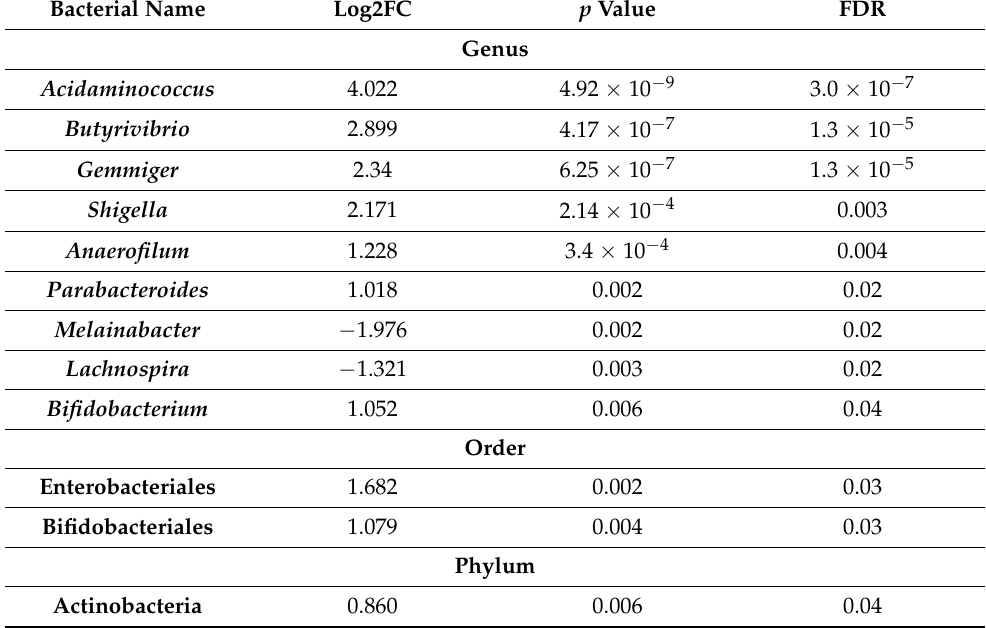
Table 4. Bacterial taxa significantly different between women who consumed less than 3 serv/d of adjusted UPFs and more than 5 (from genus to phylum) analyzed by EdgeR.